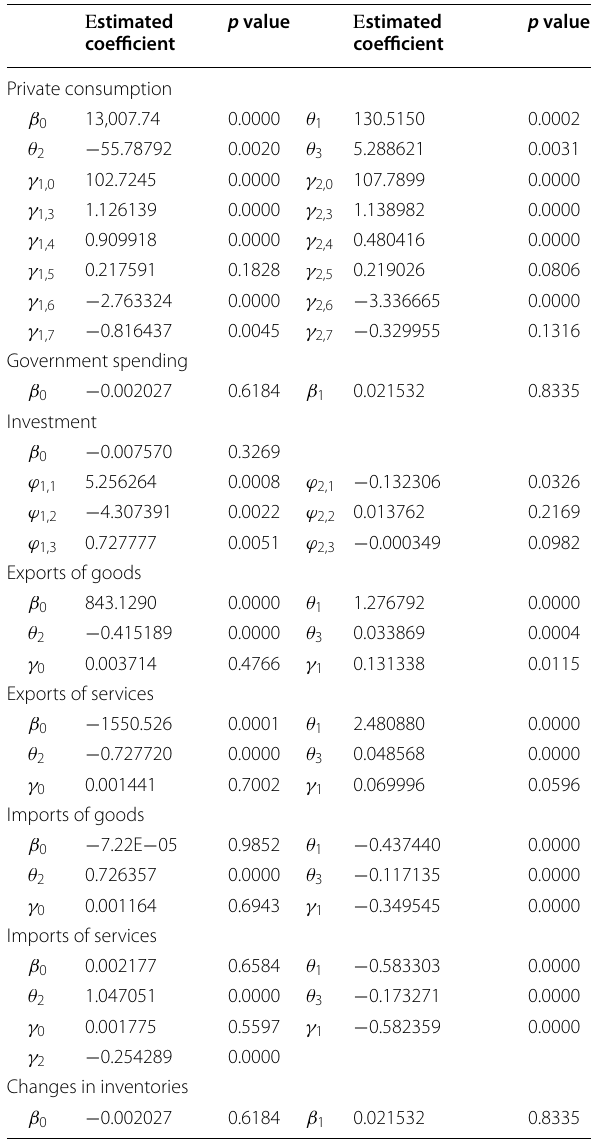
Table 5 D-model’s estimated coefficients with their p values based on the latest available information